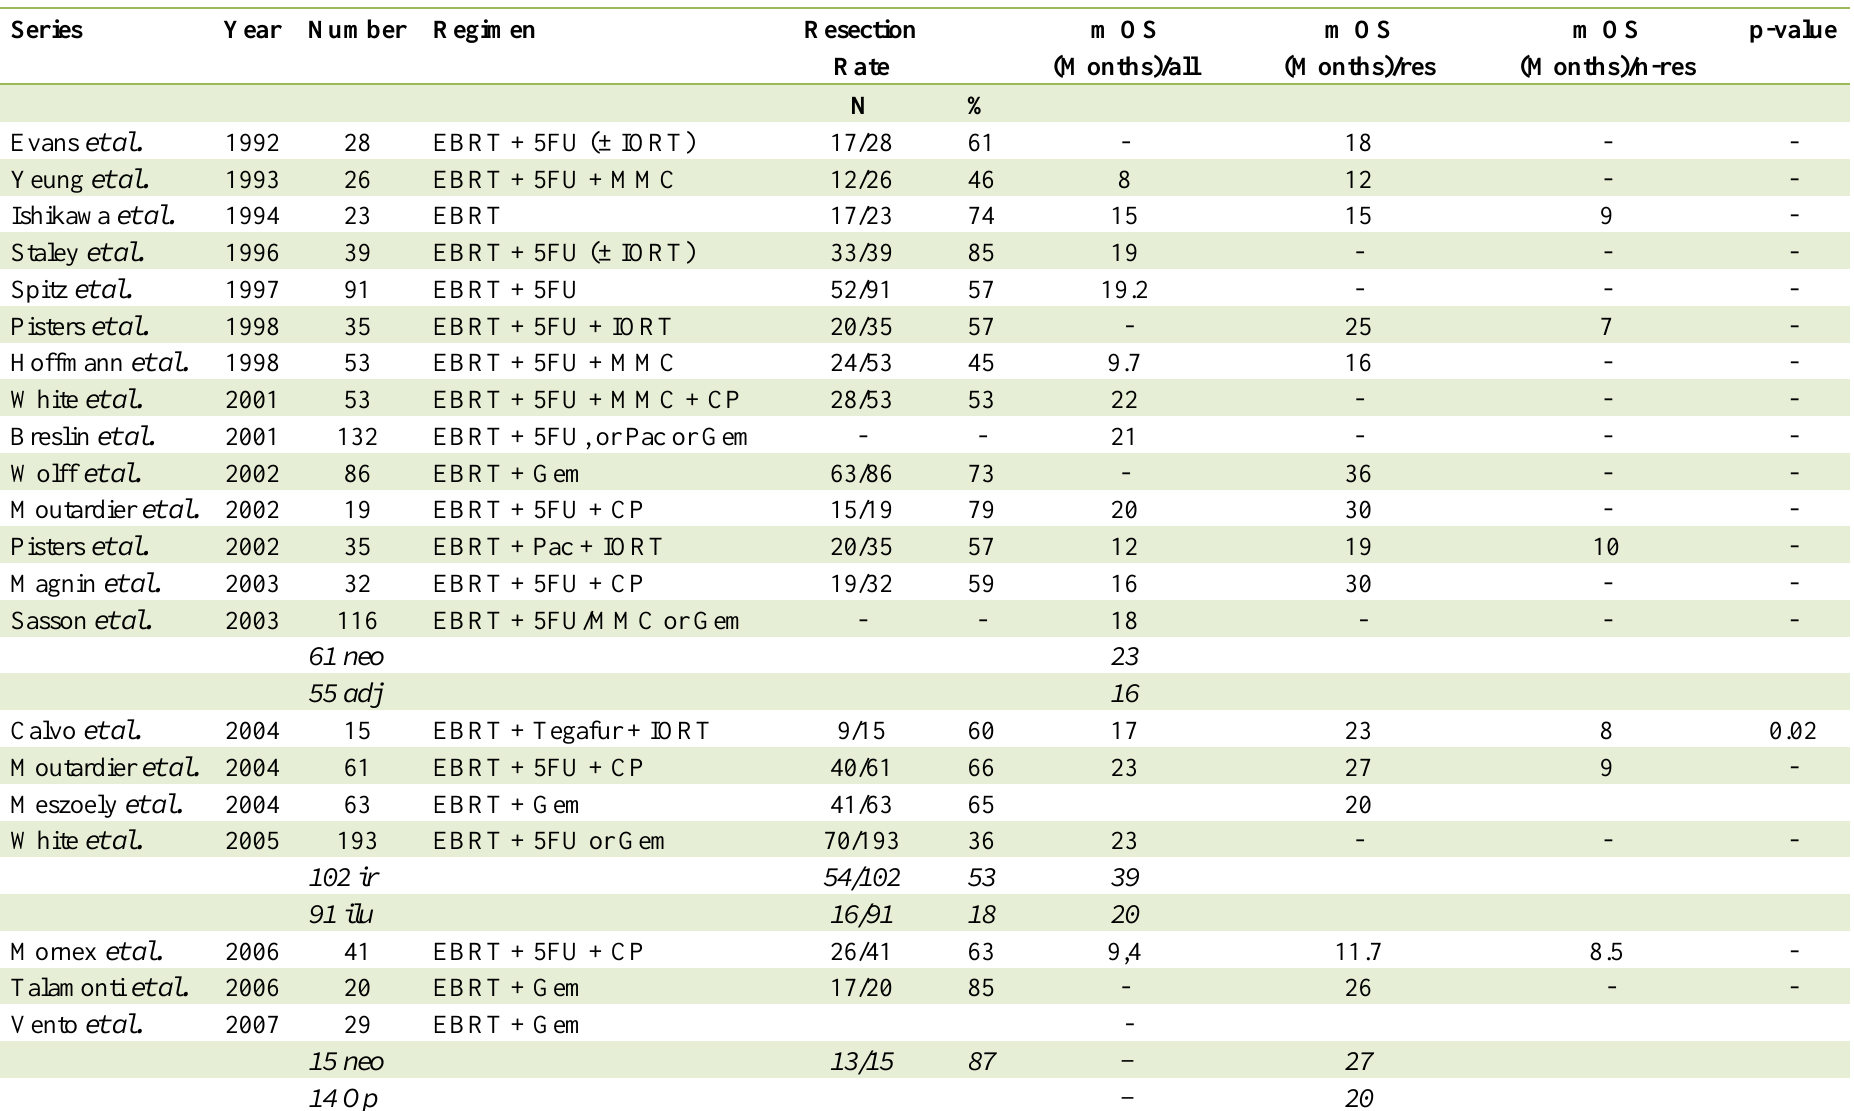
Table 1. Neoadjuvant Therapy for Resectable